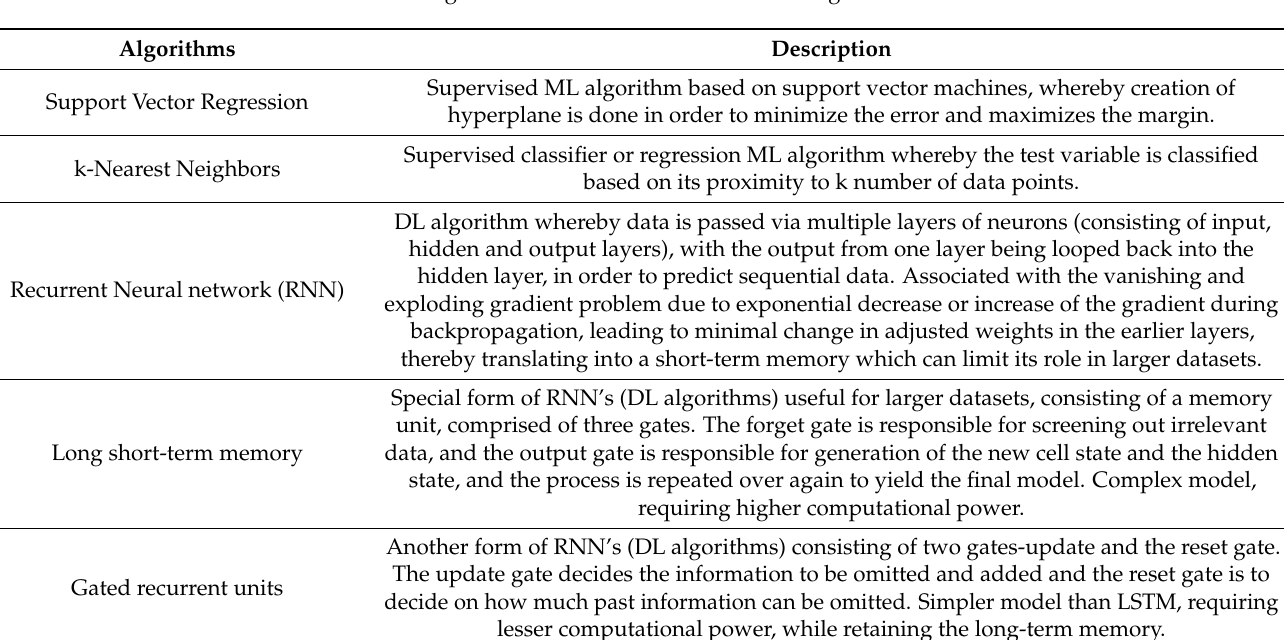
Table 1. AI algorithms used in time-series